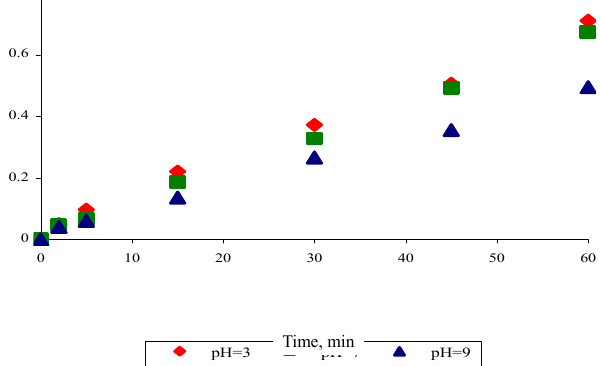
/ZnO at 3 = 15 mg/L. o